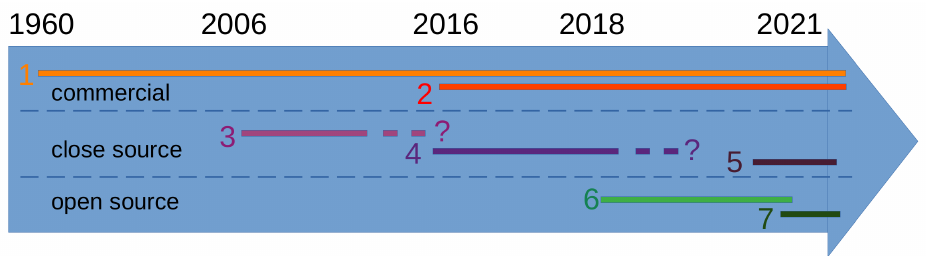
Figure 1. Overview of waves in ice instruments, distinguishing between (i) commercial instruments, (ii) closed-source instruments, (iii) open source. Commercial instruments have been available for a long time, in particular the Datawell Waverider series of instruments ( 1 ), which goes back all the way to the 1960s [48]. More recently, the Sofar Spotter ( 2 ) has become a viable, lower-cost alternative, though there are a number of limitations, particularly regarding battery autonomy [49] and the price. A number of groups have developed satellite-connected autonomous instruments that have been described in research articles, but that remained closed source. A few instruments we know about were released in 2006 ( 3 ) [47,50], 2016 ( 4 ) [40], and 2021 ( 5 ) [24]. By contrast, our group has decided to release our designs as open source, so that they can be freely used and improved by other groups, starting in 2018 ( 6 ) [51] and now with the present design ( 7